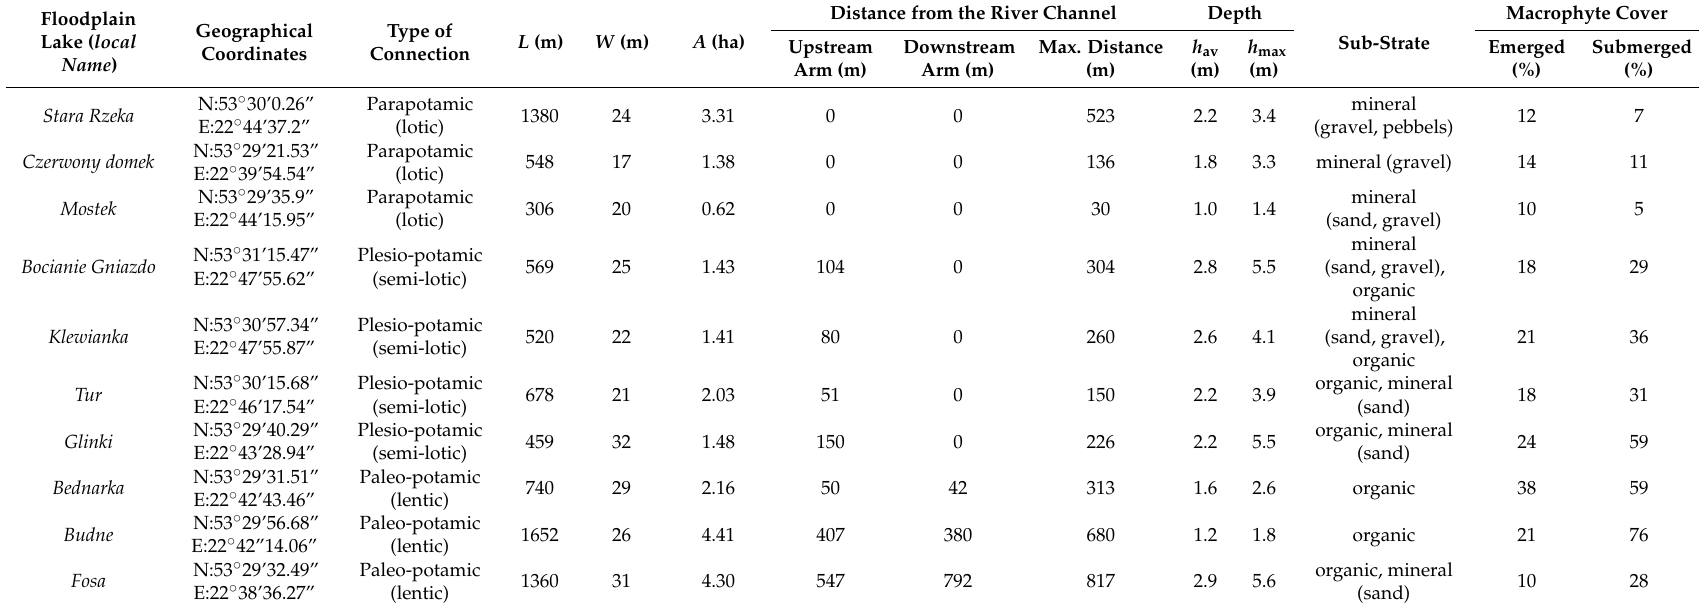
Table 1. Selected morphological parameters of the studied floodplain lakes in the Middle Basin of the Biebrza River. Denotations: L , length; W , width, h av , mean depth; h max , maximum depth; A , area; Eme, emerged vegetation; Sub, submerged